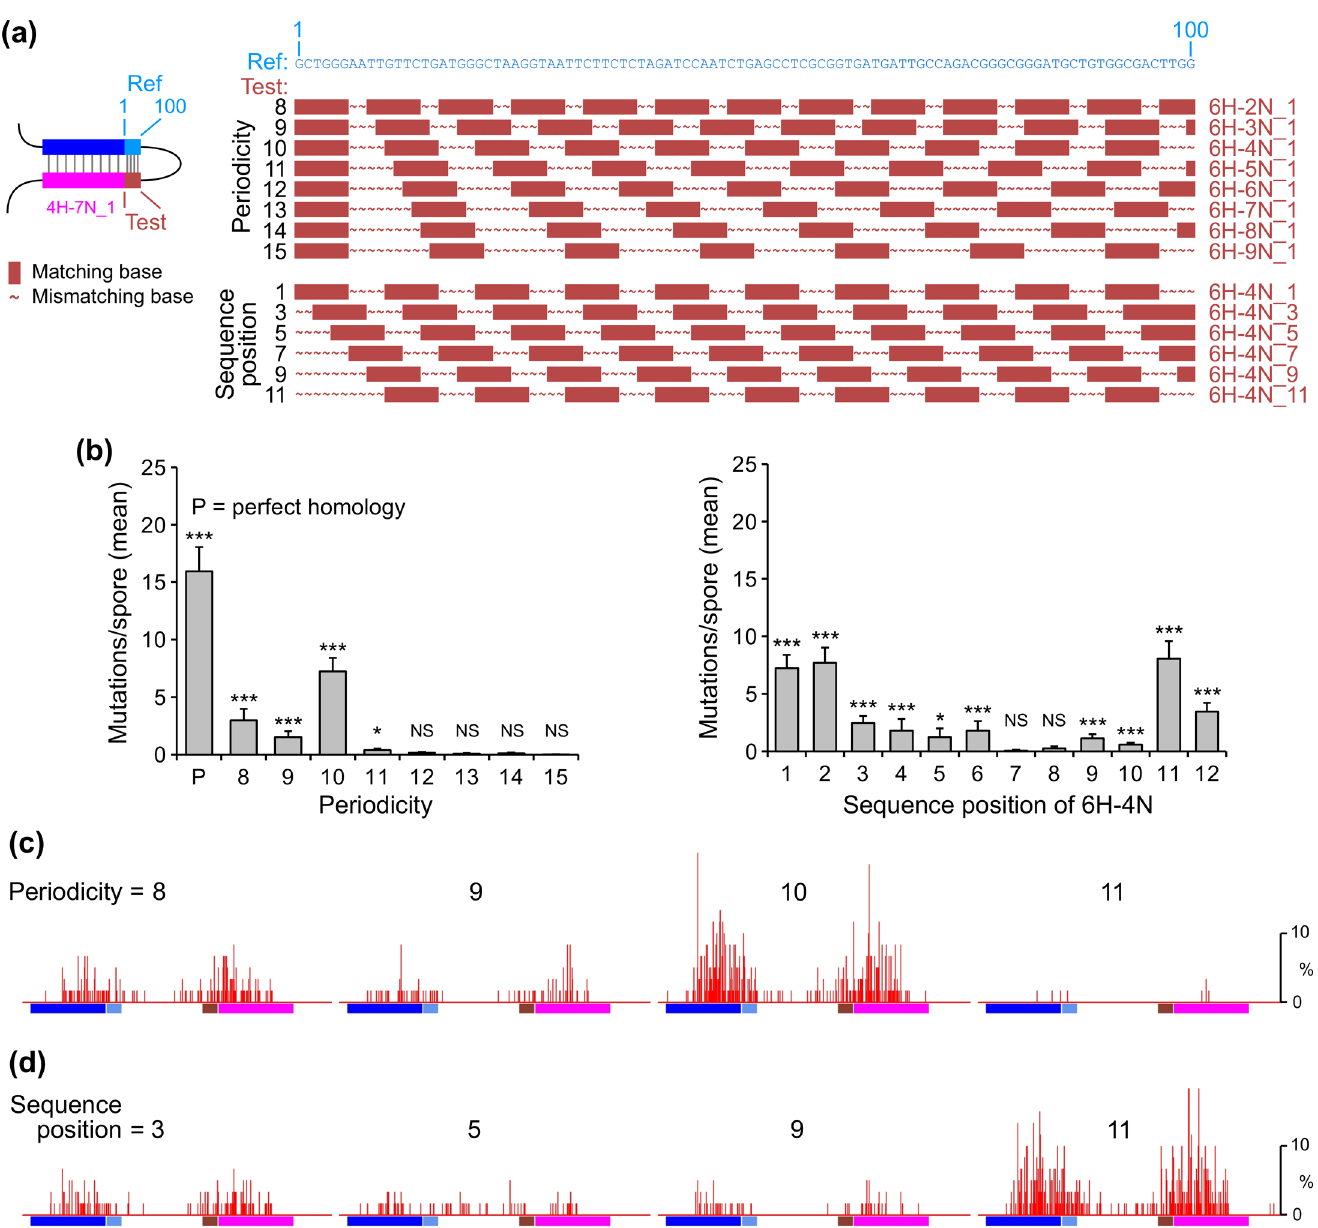
Fig 4. Interplay between the 500-bp interspersed homology 4H-7N_1 and different patterns of interspersed homology in the adjacent 100-bp region. (a) Reference/test combinations are created for a region derived from the 100-bp insert (Fig 2D: construct v). All interspersed homologies (as described in Fig 1) have a homologous unit length of 6 base-pairs and are varied with respect to periodicity (from 8 to 15) and sequence position (from 1 to 12, for the selected periodicity of 10). We note that the last homologous unit in 6H-4N_2, 6H-4N_3 and 6H-4N_4 was inadvertently extended by 3, 2 and 1 base-pairs, respectively. (b) The mean number of RIP mutations (measured as in Fig 2C) for repeat constructs described in (Panel a). (c) RIP mutation profiles for selected repeat constructs with periodicities of 8, 9, 10 and 11, corresponding to homology patterns 6H-2N_1, 6H-3N_1, 6H-4N_1 and 6H-5N_1, respectively, as described in (Panel a). (d) RIP mutation profiles for selected repeat constructs with sequence positions of 3, 5, 9, and 11, and corresponding to homology patterns 6H-4N_3, 6H-4N_5, 6H-4N_9 and 6H-4N_11, respectively, as described in (Panel